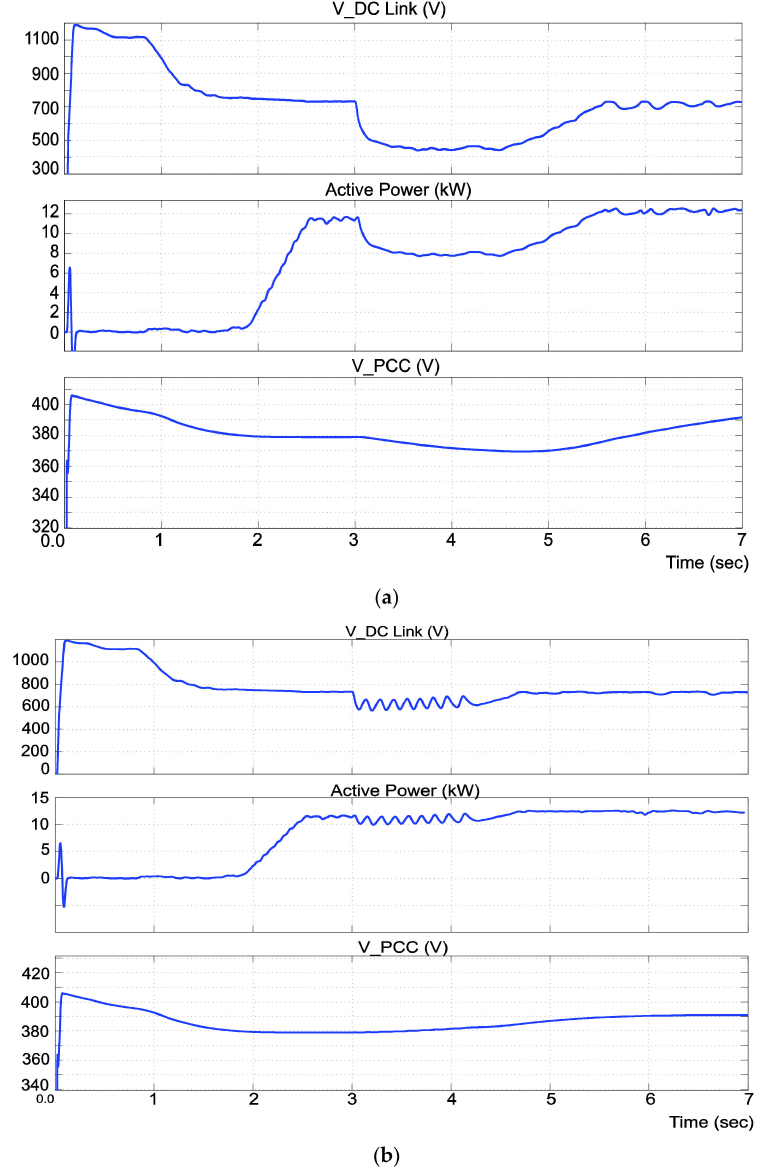
Figure 8. VPCC control with: ( a ) conventional controller and ( b ) proportional HBC. VPCC reference is changed from 1.0 to 1.02 pu at t = 3